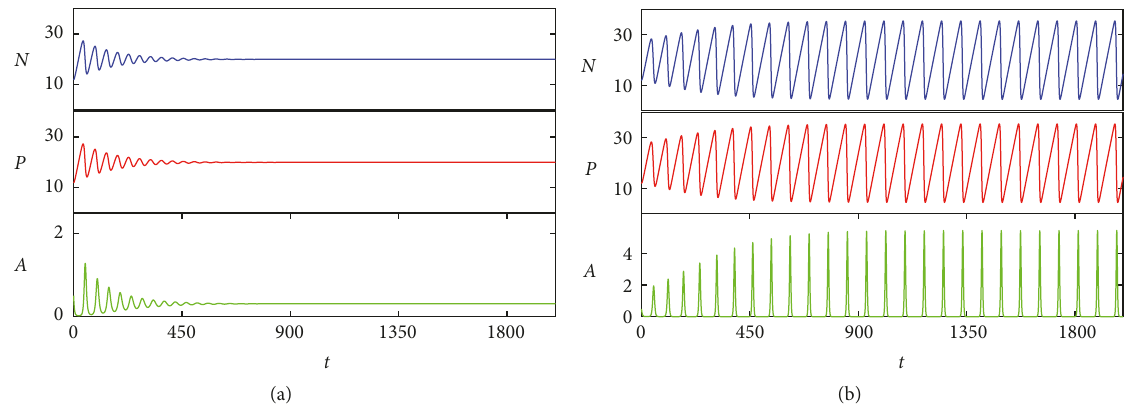
𝜏 = 0,1,2, 3 , 2 in (39) for j